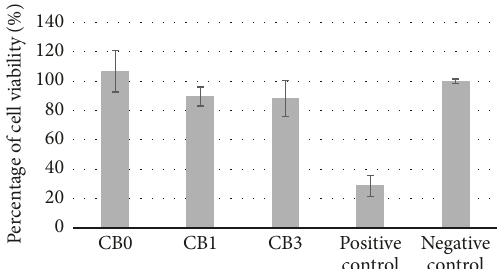
Figure 6: Indirect cytotoxicity of membranes against primary dermal